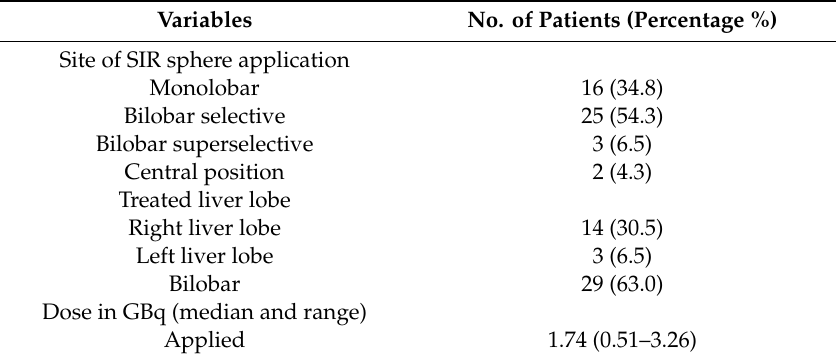
Table 4. Procedural characteristics of TARE (transarterial radioembolization)